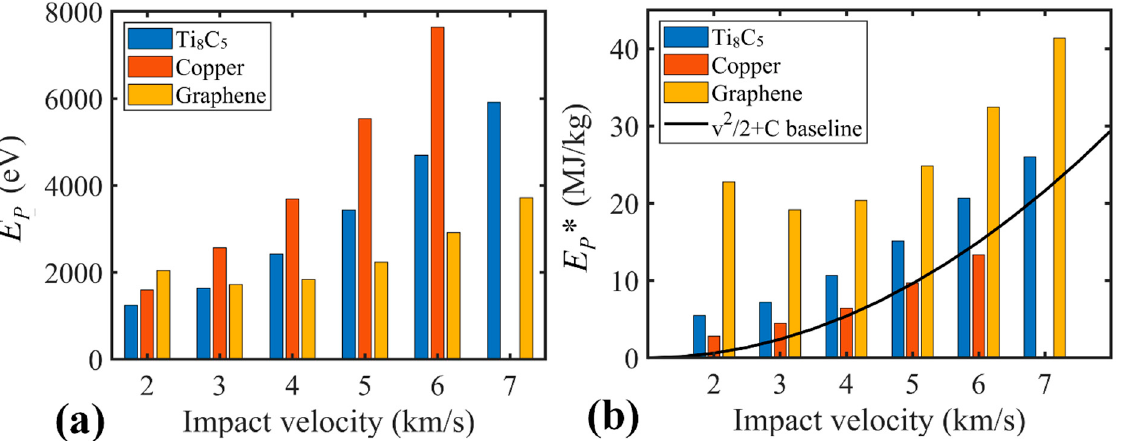
Figure 8. Performance of nanosheets’ impact with projectiles of various velocity amplitudes. ( a ) Penetration energy and ( b ) Specific penetration energy as a function of impact velocity for Ti 8 C 5 , graphene and Copper nanosheets.